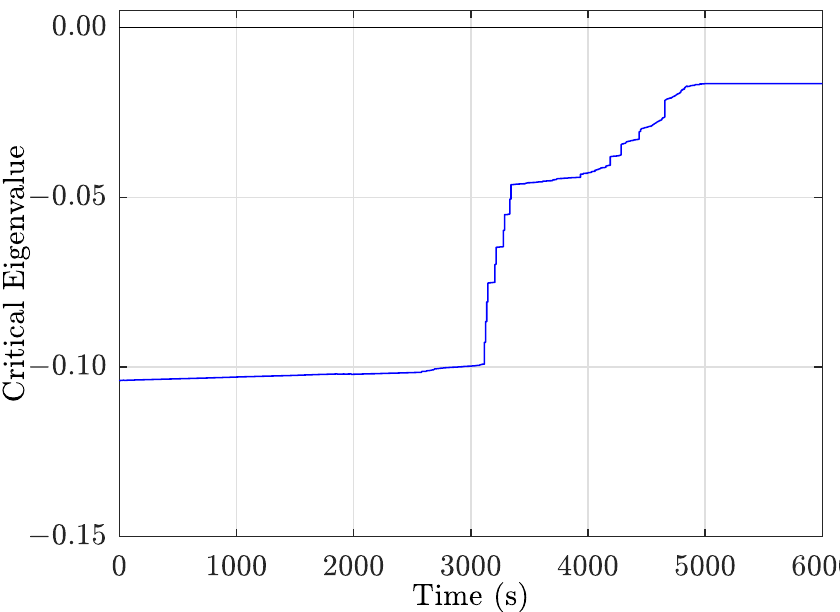
Figure 12. Critical eigenvalue response, stable